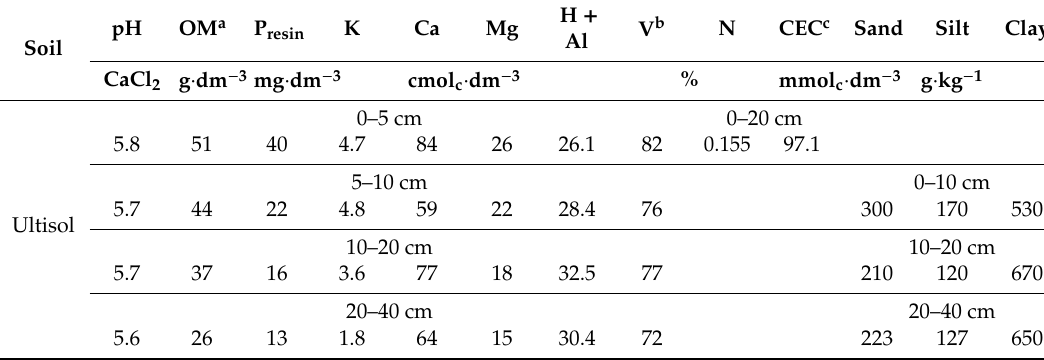
Table 1. Fertility and granulometry of soils at di ff erent experimental sites at depths of 0–5, 5–10, 10–20, and 20–40 cm, in Botucatu, S ã o Paulo, Brazil. Data correspond to the site conditions at the establishment time. Adapted from